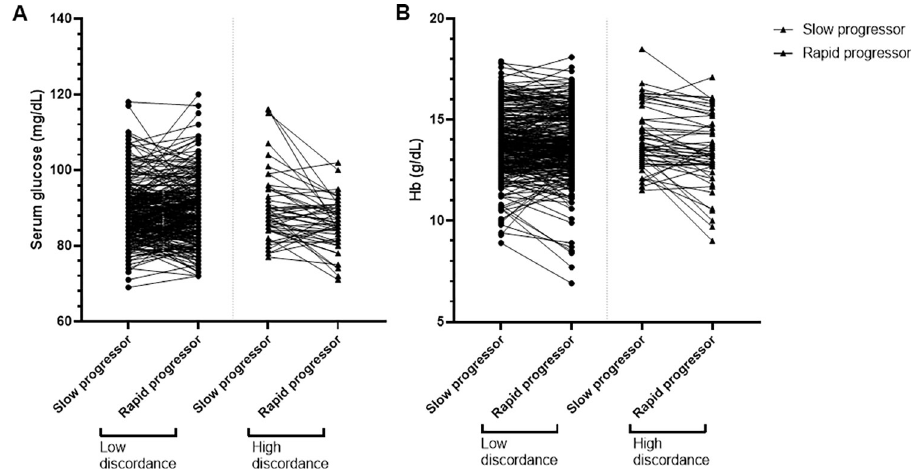
Fig 3. Blood glucose and hemoglobin levels according to the difference in eGFR decline in twins. With the dotted line as the center, the plot on the left and right represent (A) glucose and (B) hemoglobin levels in the low and high discordance groups, respectively. Circular dots indicate the slow progressor among the twins, whereas the triangular dots indicate the rapid progressor. The lines connecting the circle and triangle dots represent each pair of twins.